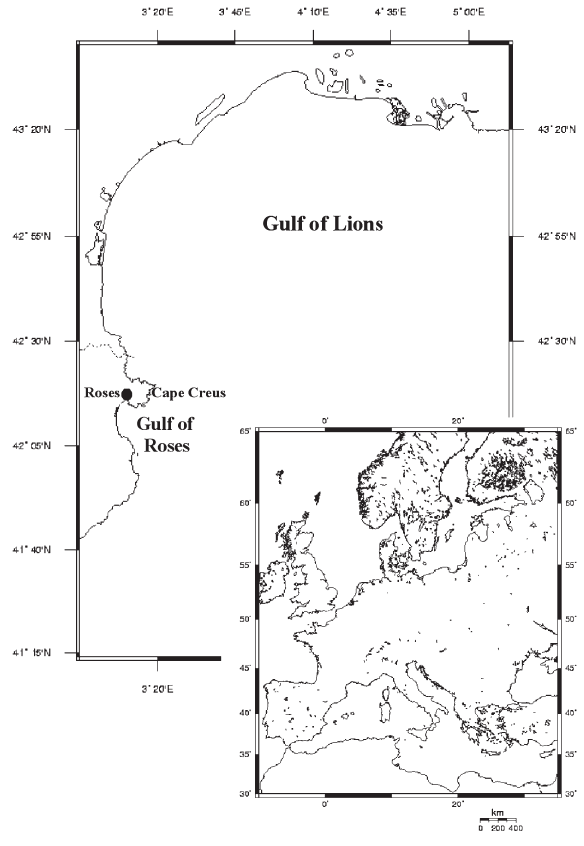
F IG . 1. – Location of the study area (Gulf of Lions and Gulf of Roses; NW Mediterranean) showing the fishing port of Roses where landings are recorded monthly and length sampling was